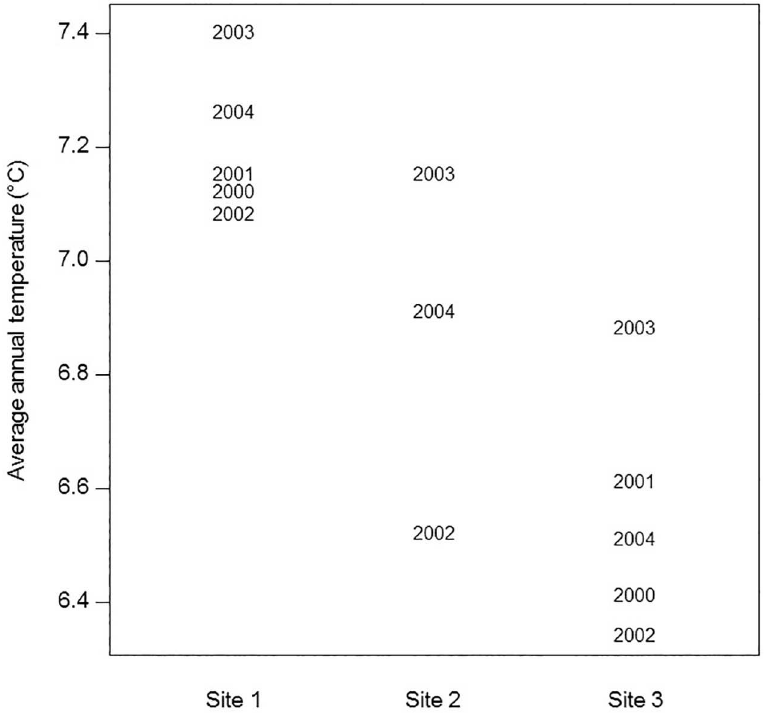
Fig 3. Average annual temperature (˚C) measuredat Sites 1–3. Points are indicatedby the year the temperatures were